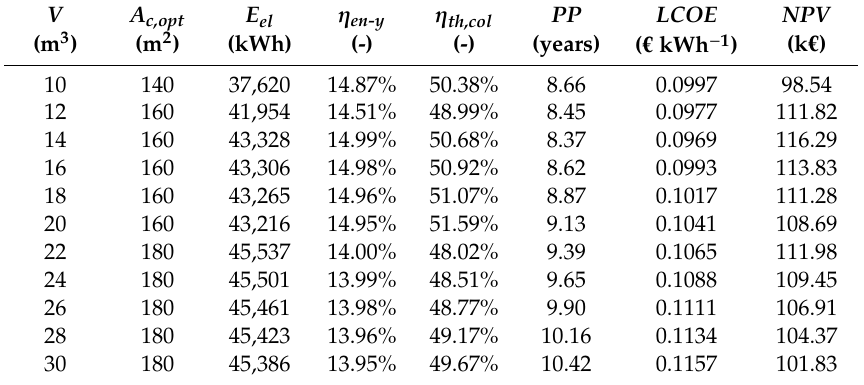
Table 5. Optimum collecting areas for di ff erent storage tank volumes for minimizing the payback period.